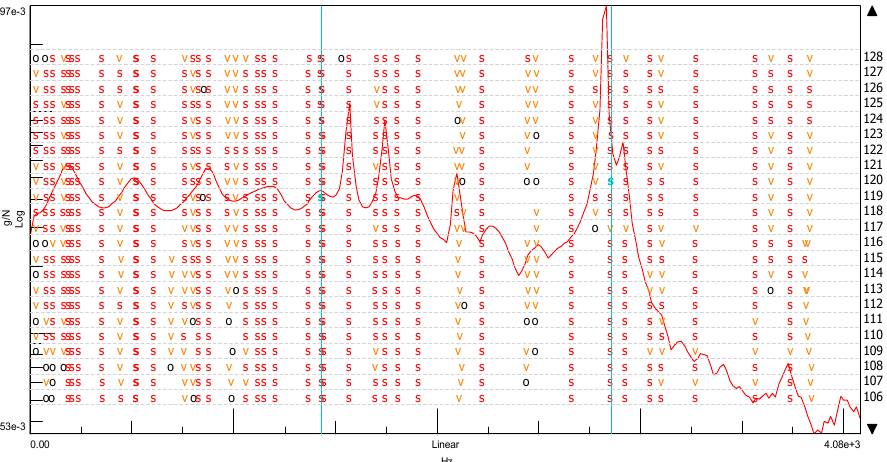
Figure 20. Stabilization diagram made of the spectral transition function FRF (using the SUM index) for the ordinary concrete cube (s—stable frequency field, v—modal vector, o—empty field).